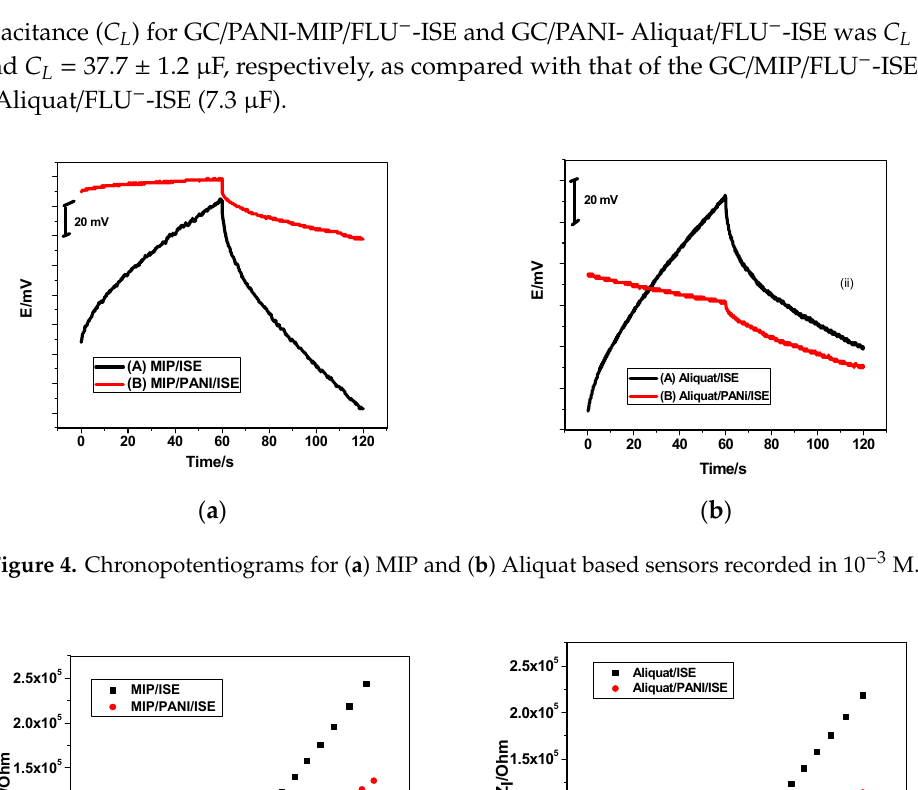
( b ) Figure 3. The time-dependent potential response curve of the proposed electrodes integrated with ( a ) MIP nanobeads curve and ( b ) aliquat. 3.3. Potential stability By current-reversal chronopotentiometry, the potential stability of flucarbazone ISEs were evaluated (Figure 4). The potential drift of the GC/PANI-MIP/FLU - -ISE and GC/PANI-aliquat/ FLU - -